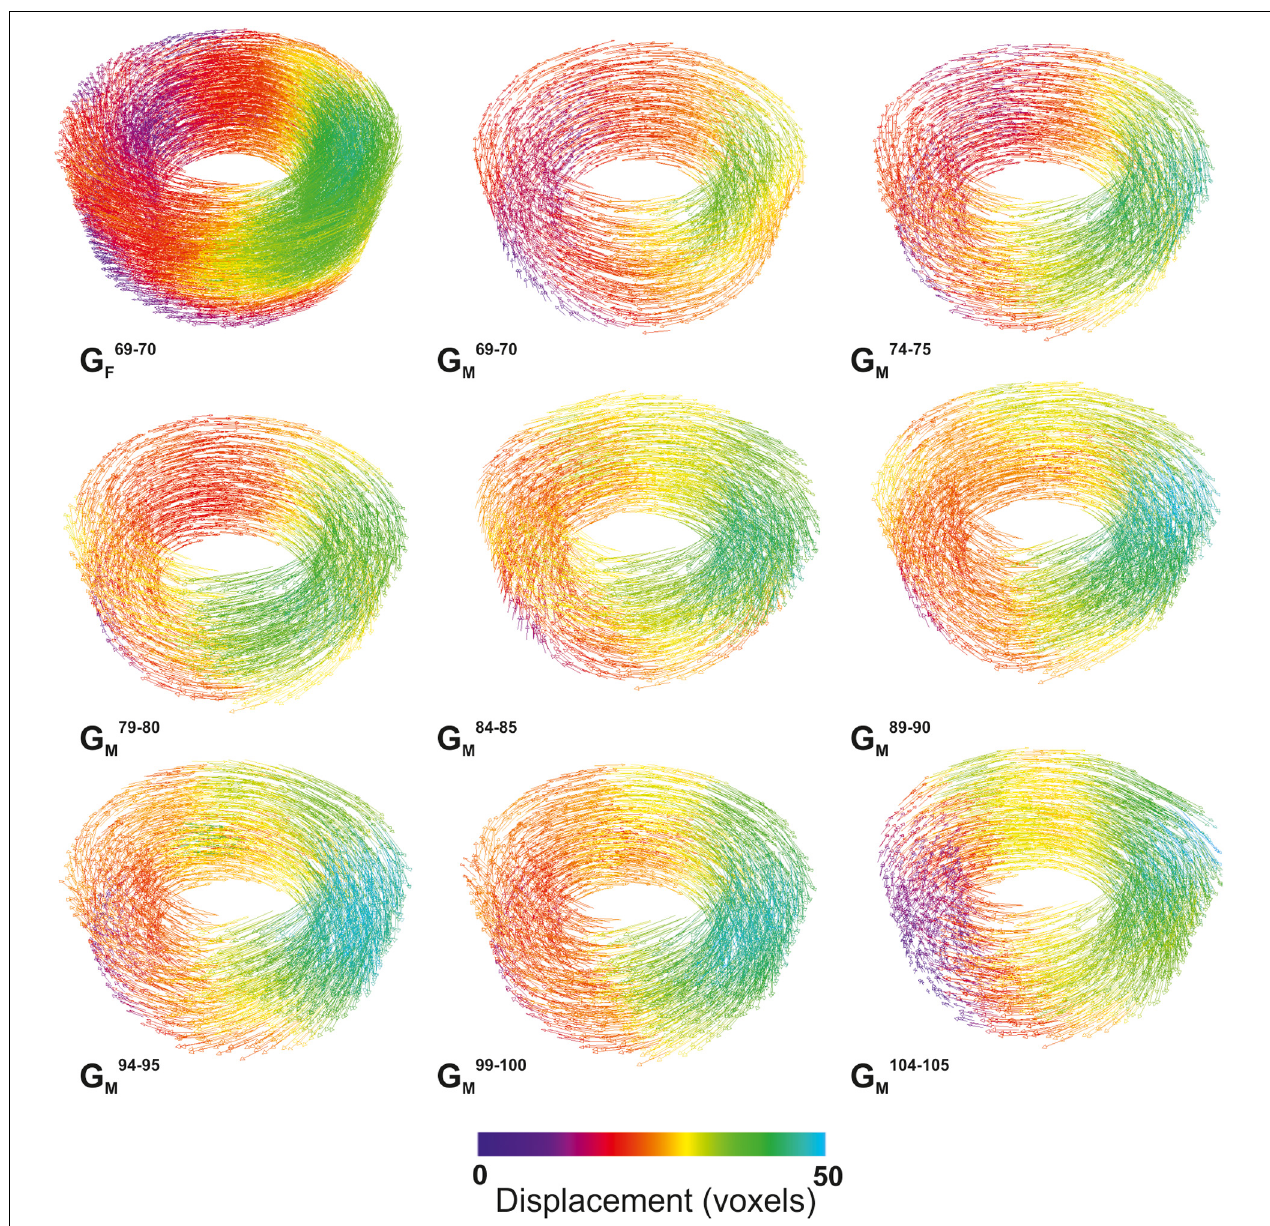
FIGURE 12 | DVC outputs from the end of the acceleration and constant deformation phase. Note the discontinuous time steps shown. The first two frames show the last G F and the equivalent G M . After this the large displacements meant the G F iteration was unnecessary. Workflow for iterations as shown in Figure 10 . The outputs shown were those generated on the experiment discussed in section “Bubble Bearing Magma (High Temperature)” and shown in Figures 6 , 7